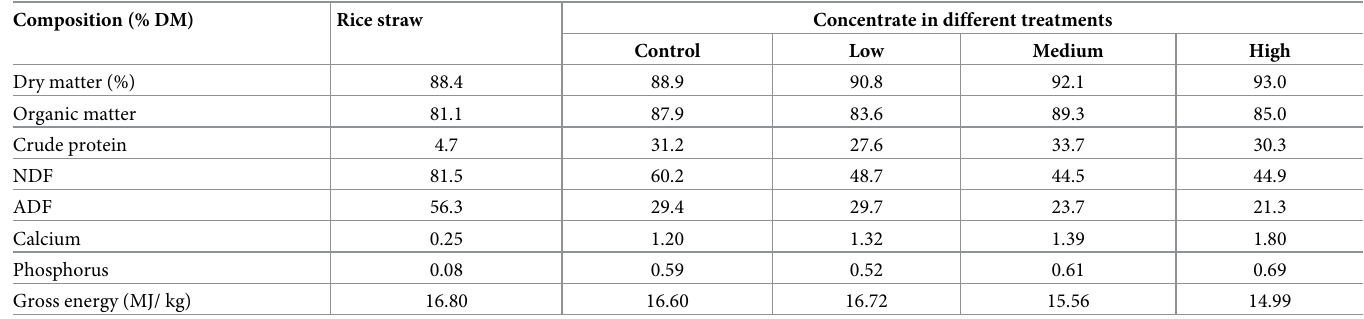
Table 2. Chemical composition of